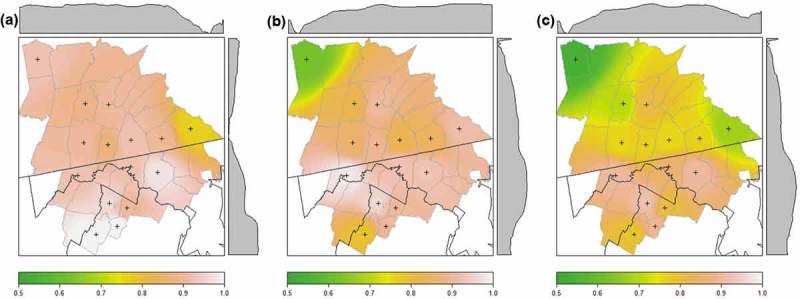
Surfaces showing the interpolated frequencies of the most susceptible genotypes at (a) codon 95, (b) codon 96, and (c) joint genotypes for white-tailed deer in the Mid-Atlantic region of the United States. Axis plots display spatial trends in the frequency of the most susceptible genotype. Sampling units used for interpolation are marked with a cross (N ≥ 20 individuals).